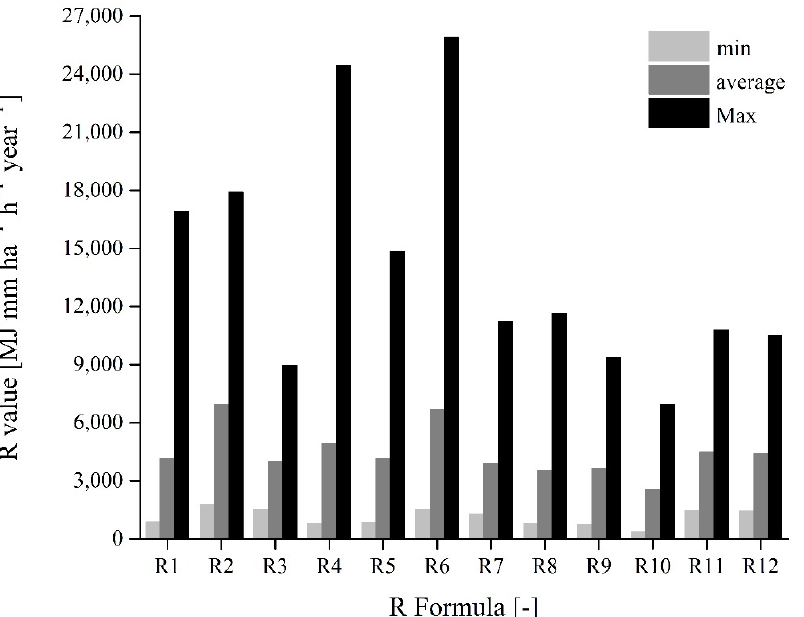
Figure 6. Minimum, average, and maximum rainfall erosivity values obtained with the 12 selected formulas.